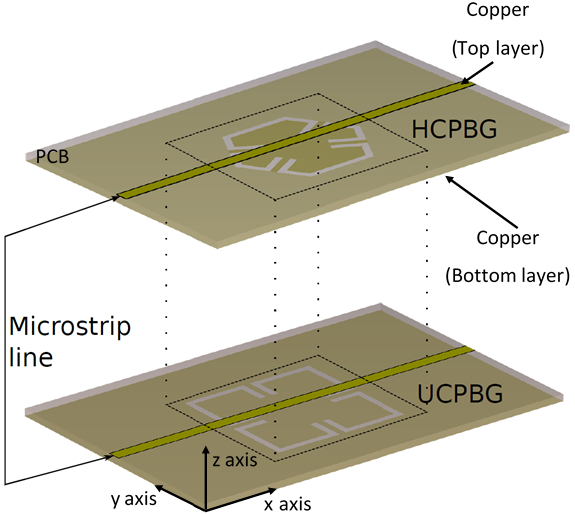
Figure 1. Reference diagram for simulations and